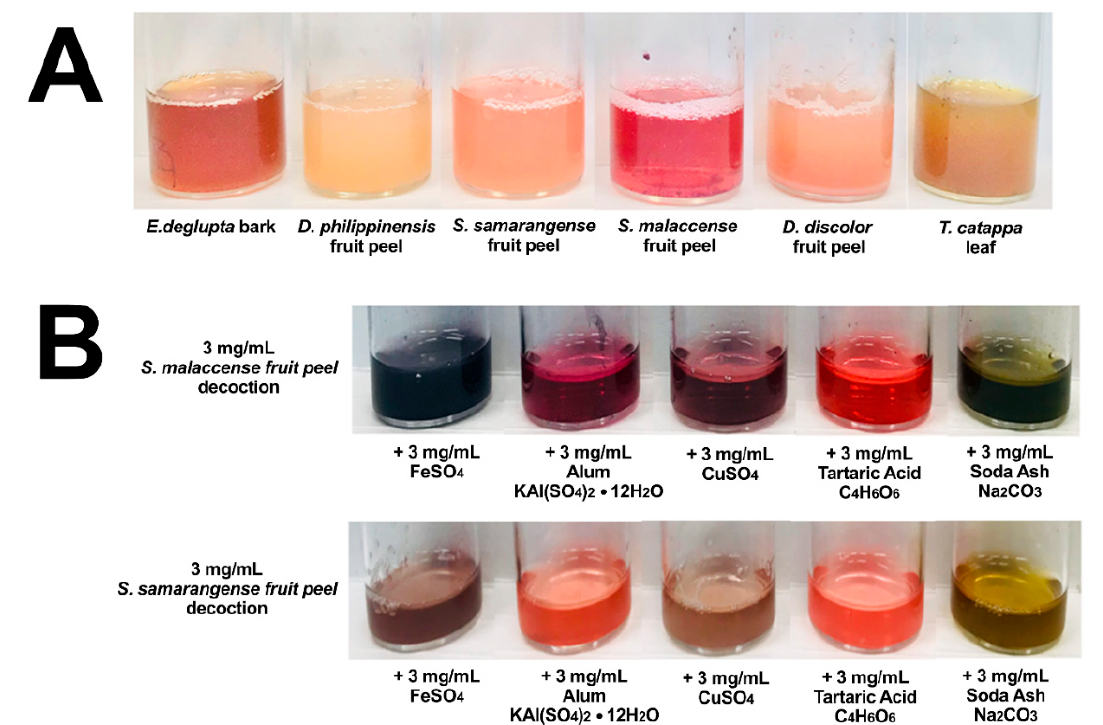
Figure 2. Extracted colorants from biowaste materials. Decoctions from five waste materials and the popular dye source T. catappa are displayed in ( A ). In addition, the significant effect of mordants on color is demonstrated in terms of Syzygium dyes in ( B ). Additional images from other dye samples can be found in Figure S1.